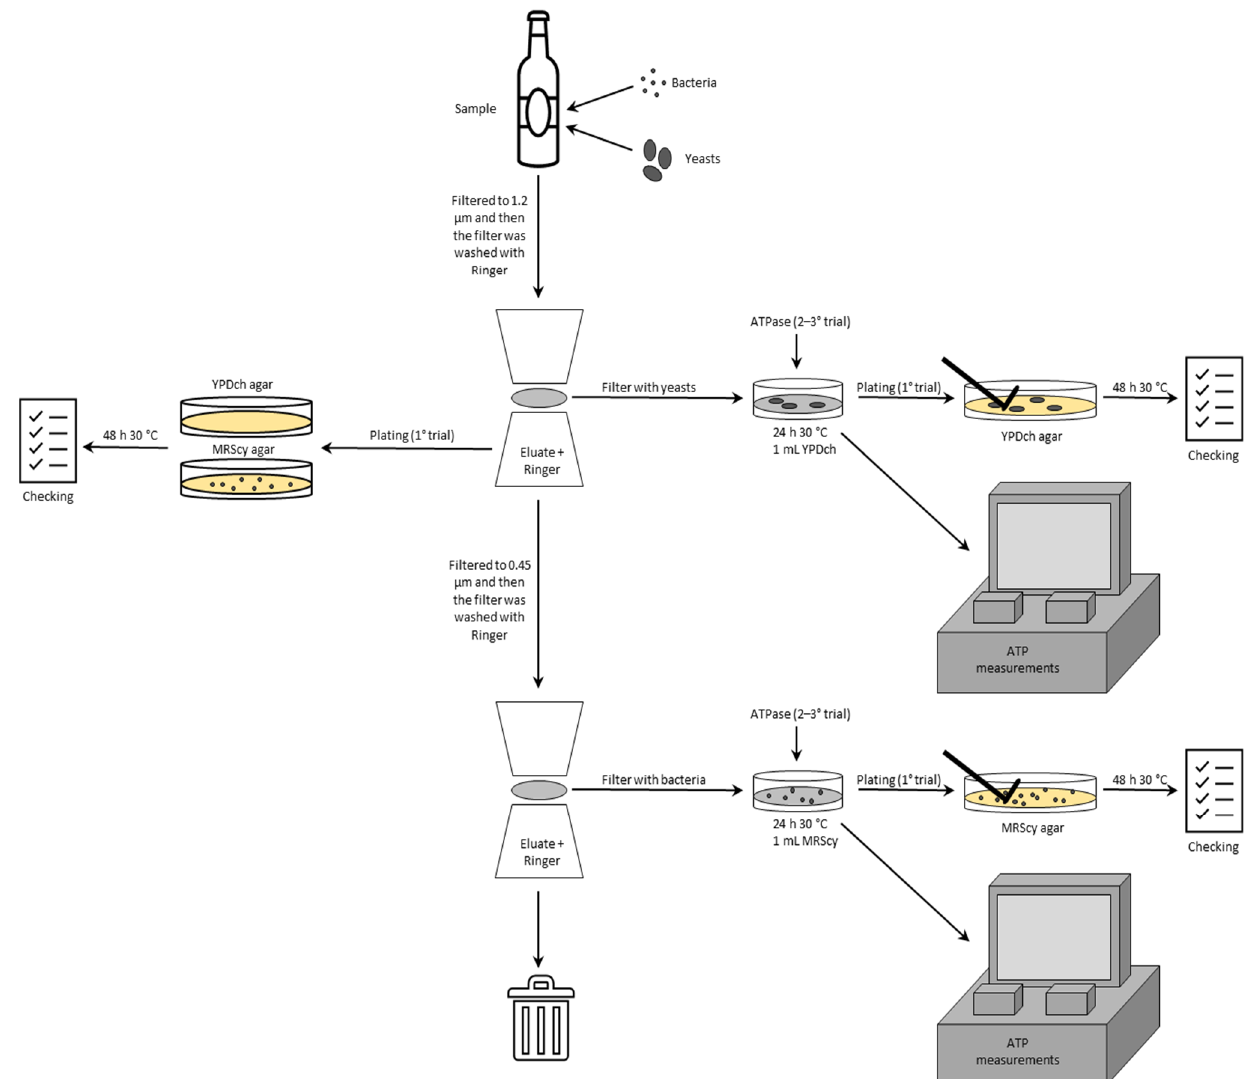
Figure 1. Flow sheet of the analytical method using ATP bioluminescence.